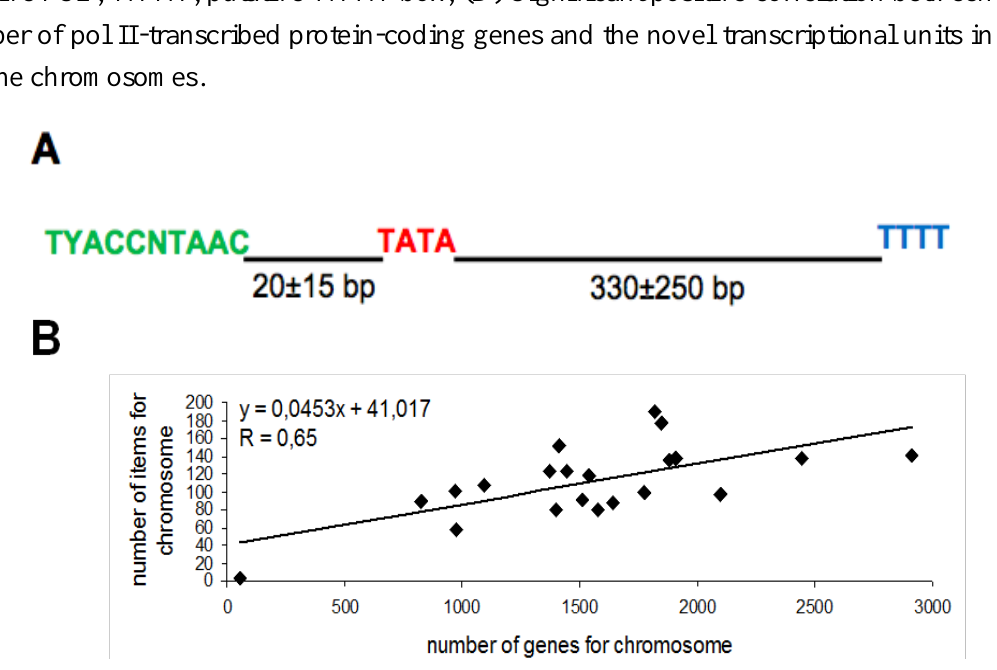
Figure 1. ( A ) 38B transcriptional unit and its functional elements: